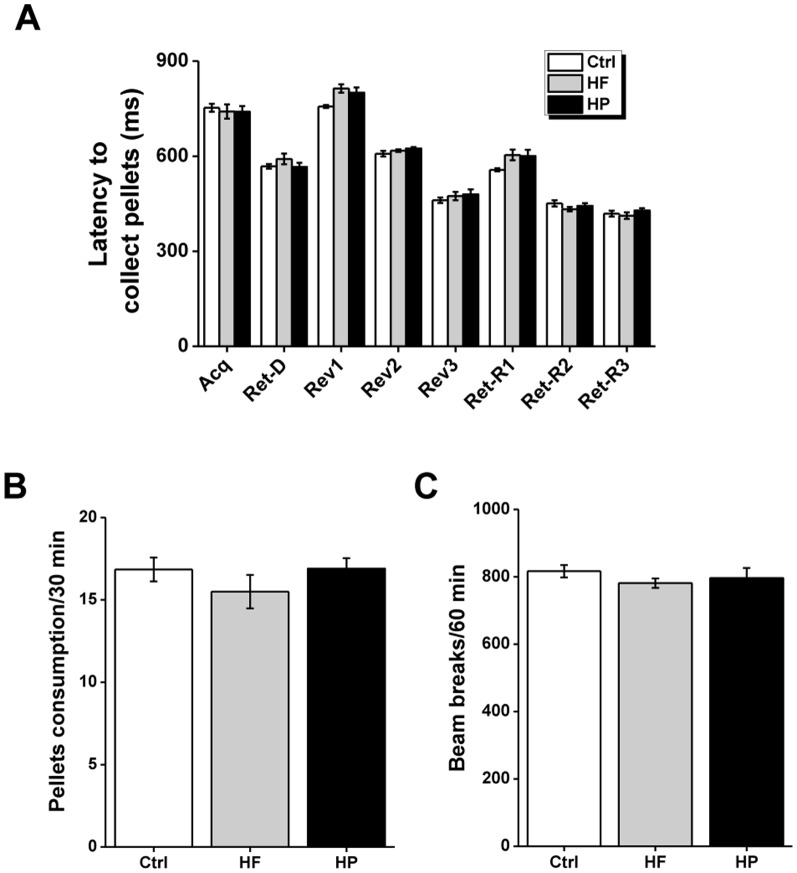
Feeding behaviors and locomotor activity of offspring in or after the VDSRL task.(A) Latencies to collect the food during acquisition (Acq), retention of spatial discrimination (Ret-D), reversal phase (Rev1-3), and retention of reversal 1–3 (Ret-R1-3) in the VDSRL task. A series of three reversals (reversal 1–3: Rev1–3) were performed. Between successive reversals, animals were given a session to test retention of the previous reversal phase (Ret-R1–3). *p<0.05; **p<0.001. (B) Food comsuption during a 30-min test session after the VDSRL task (n = 10 in each group). (C) Number of beam breaks during a 60-min test session after the VDSRL task (n = 9 for Ctrl group, n = 10 for HF group and n = 11 for HP group.).